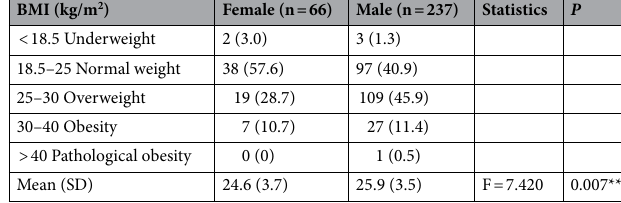
BMI (kg/m 2 ) Female (n = 66) Male (n = 237) Statistics